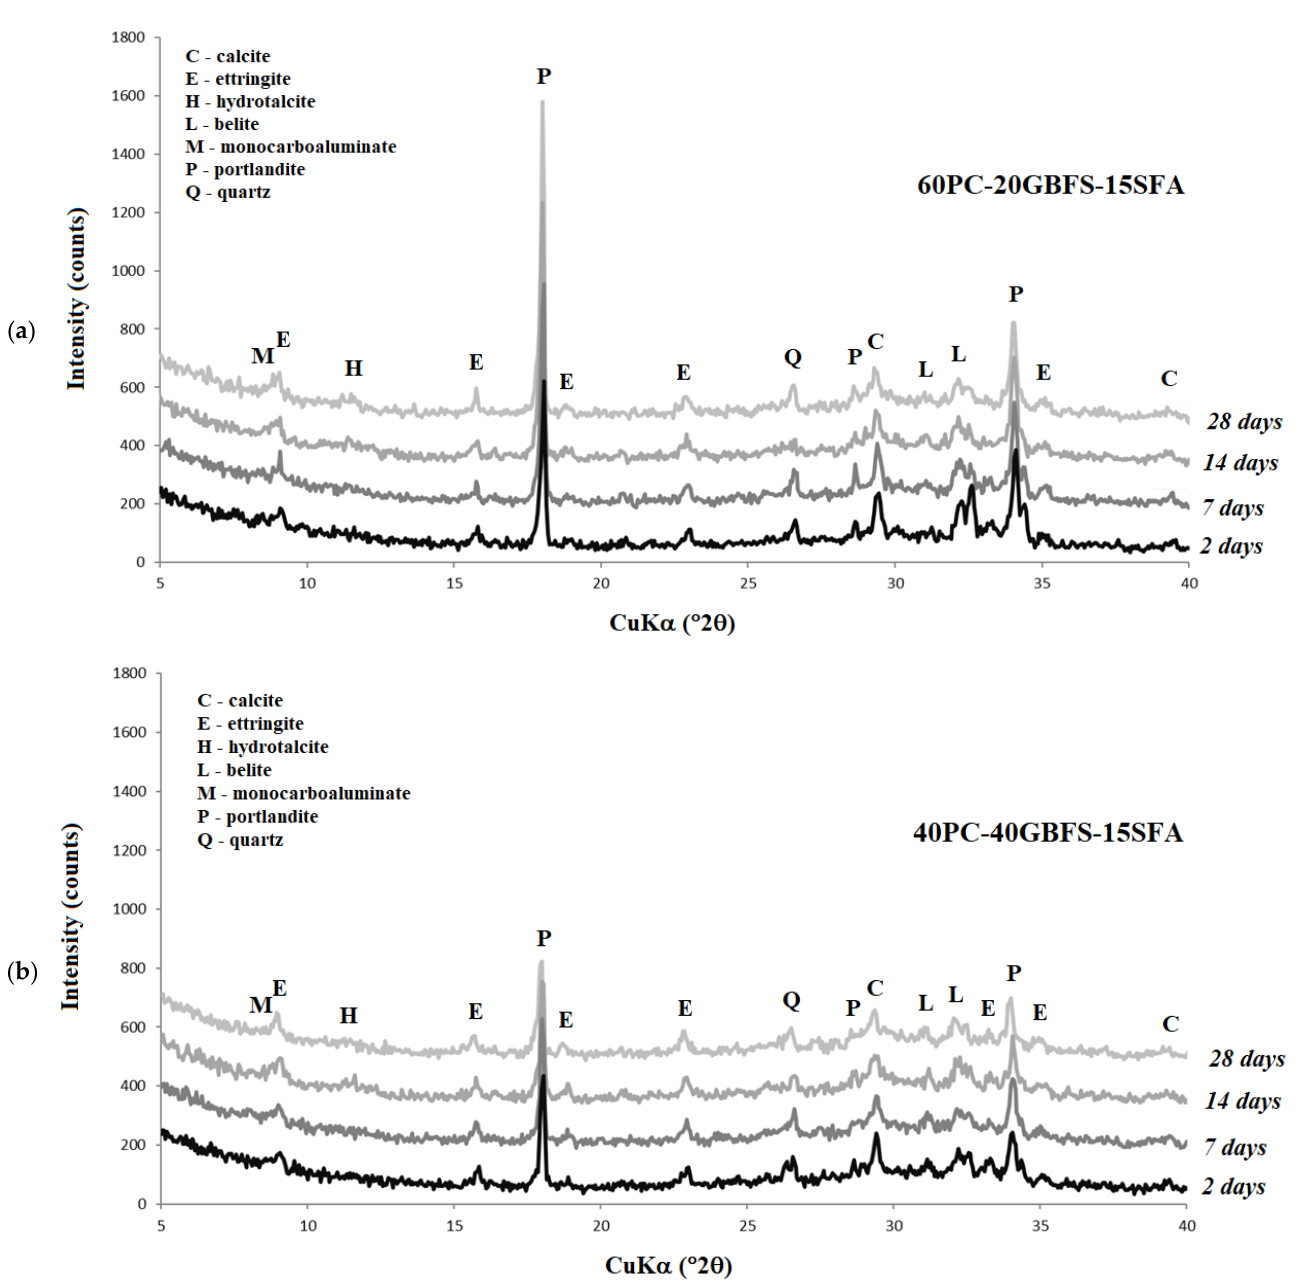
Figure 2. XRD patterns of the ( a ) 60PC-20GBFS-15SFA and ( b ) 40PC-40GBFS-15SFA cement pastes after 2, 7, 14, and 28 days.